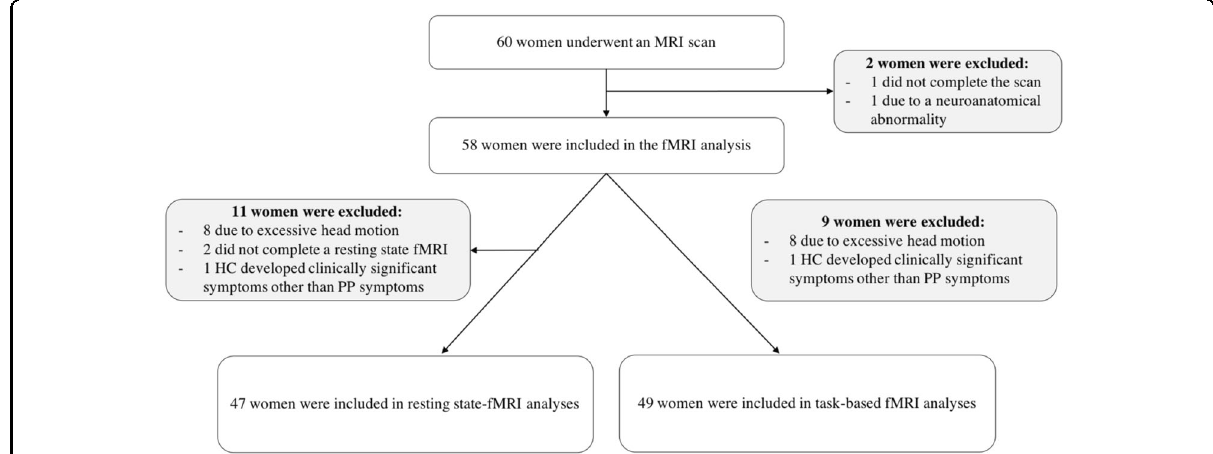
Fig. 1 Flow chart of the study. Total number of included and excluded subjects and reasons for exclusion for each fMRI analysis. From the initial sample of 60 women, 47 were included in resting state fMRI and 49 in emotional task fMRI analyses. Sample included in the MRI